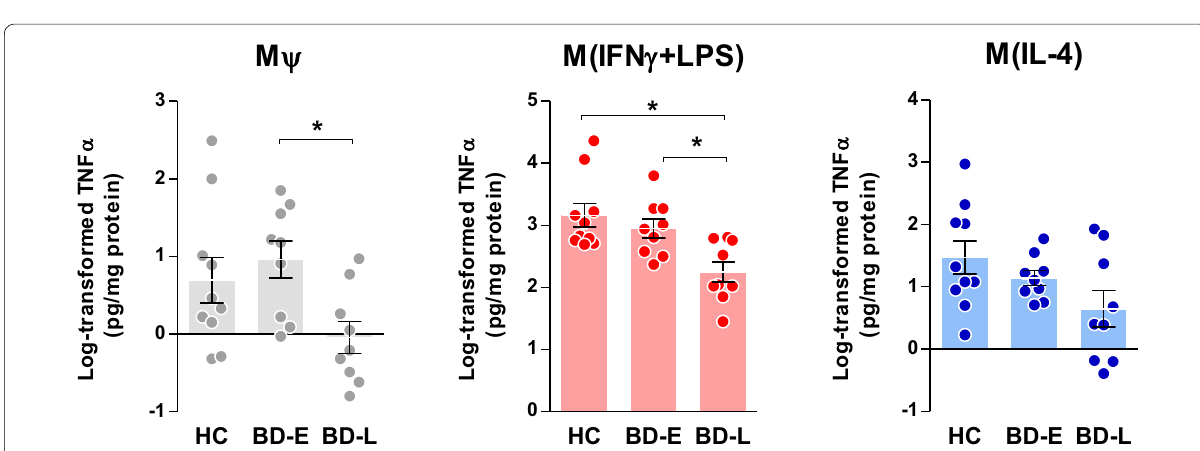
Fig. 3 TNFα levels produced by different phenotypes of macrophages derived from early (E)‑ and late (L)‑stage BD and healthy controls (HC). One‑way ANOVA followed by Tukey post hoc, data expressed by mean